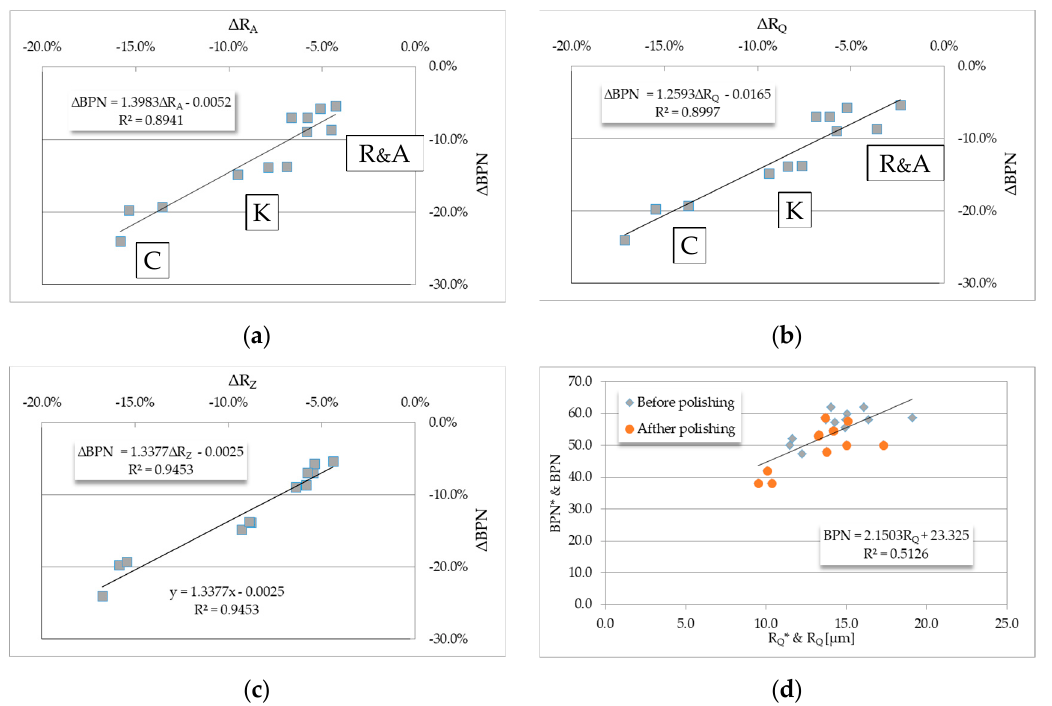
Figure 10. Relationship between percentage variations of BPN and roughness descriptors: ( a ) Δ R A vs. Δ BPN; ( b ) Δ R Q vs. Δ BPN; ( c ) Δ R Z vs. Δ BPN; ( d ) R Q * and R Q vs. BPN * and BPN.